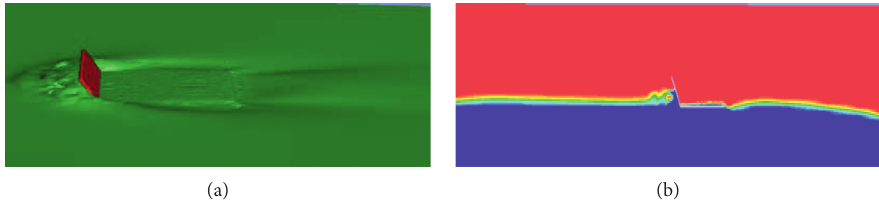
Figure 5: Simulation results of 60 ° floating plate. (a) 60 ° free waveform diagram. (b) 60 ° volume fraction